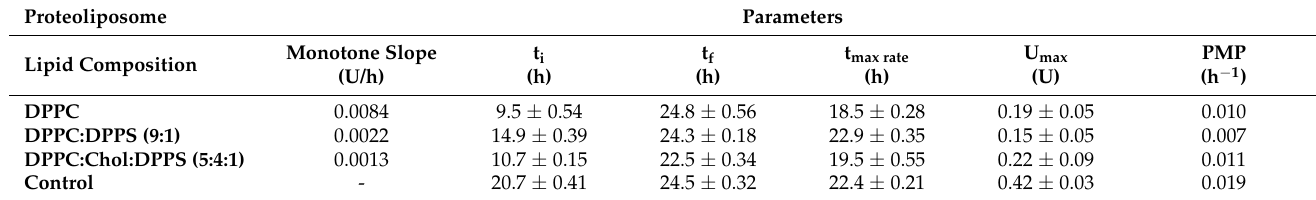
Table 2. The slope of the monotone increase in turbidity and the kinetic parameters of the nucleation process adjusted by the subtraction of monotone process (Supplementary Figures S1–S3), obtained from the mineralization curves for proteoliposomes and for AnxA6 (control) after 30 h of assay in SCL medium containing PS–CPLX in the absence of type-I collagen. Data are reported as the mean ± SD of triplicate measurements of three different proteoliposome preparations.